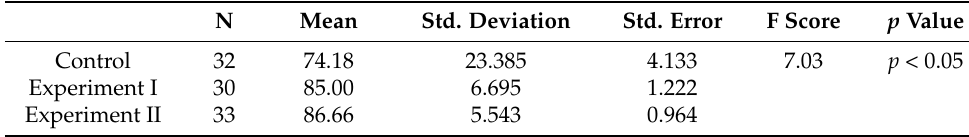
Table 2. ANCOVA results of post-test student achievement from 3 classes. N Mean Std. Deviation Std. Error p Value